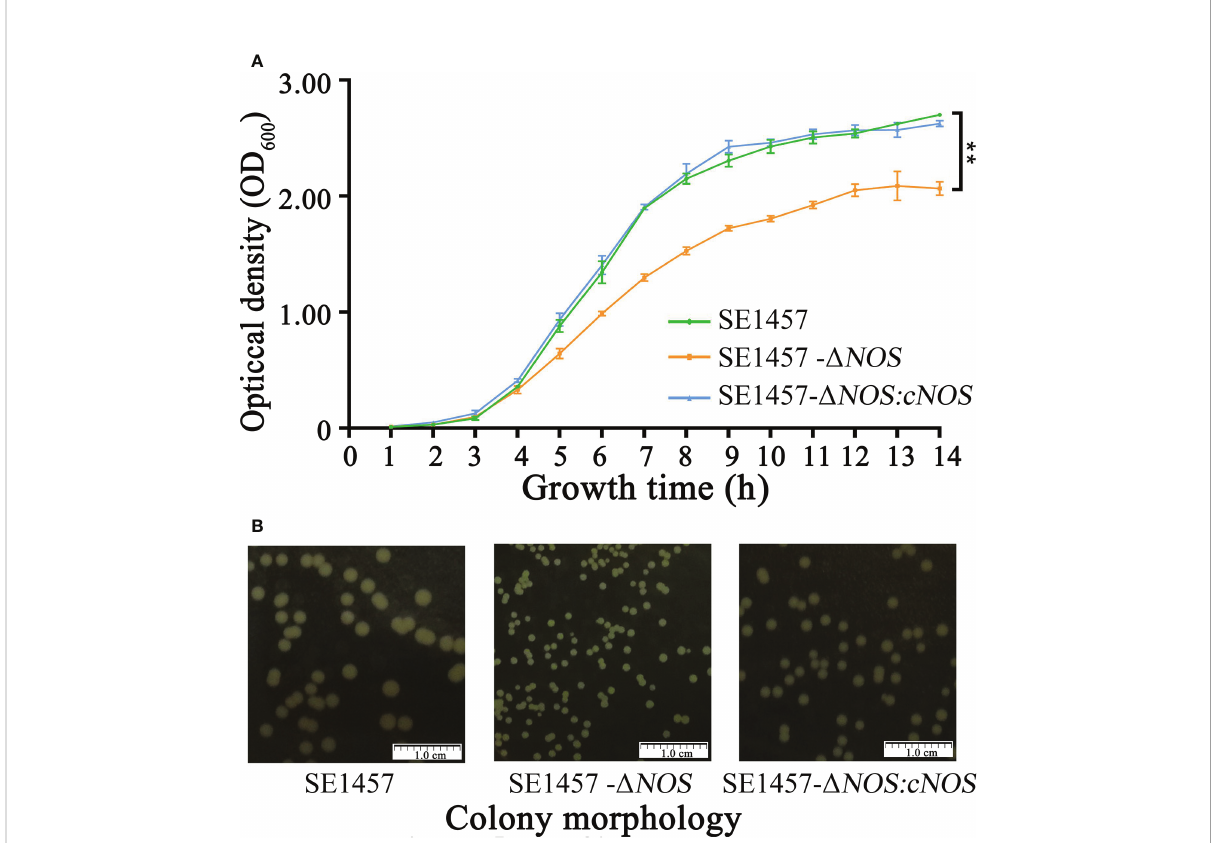
FIGURE 3 Determination of the bacterial growth curves and observation of bacterial colony morphology. (A) The bacterial growth ability was signi fi cantly attenuated following NOS deletion. (B) NOS deletion apparently affected the size of bacterial colonies. SE1457 : the wild-type strain; SE1457- D NO S: the deletion strain; SE1457- D NOS: cNO S: the complementation strain. These curves represent three independent experiments. ** p <